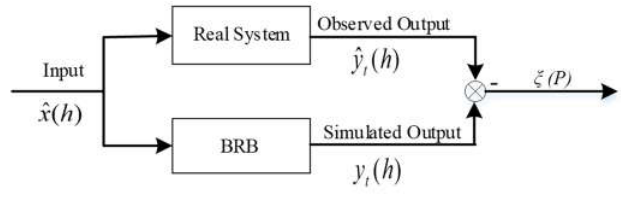
Figure 3. Framework of optimal learning model for BRB system.